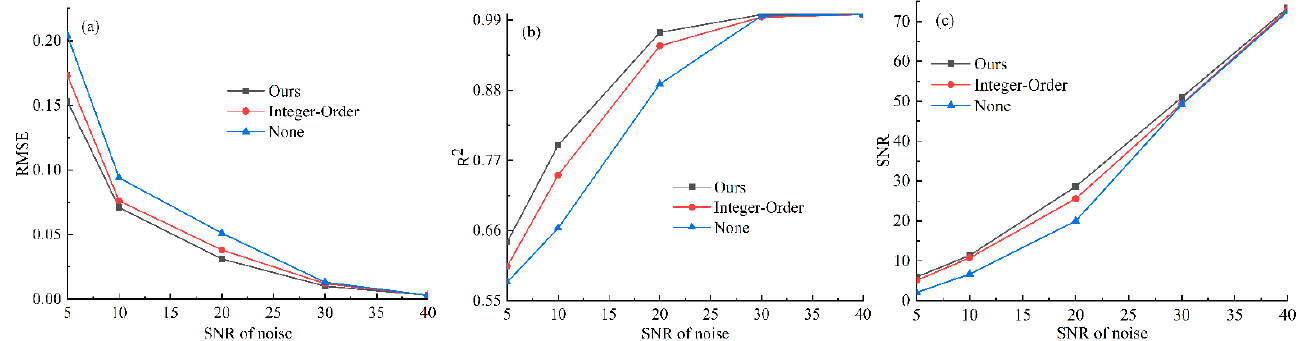
Figure 12. The quantitative denoising result with loss functions of fractional-order, integer-order, and no regularization terms. ( a ) RMSE. ( b ) R 2 . ( c )